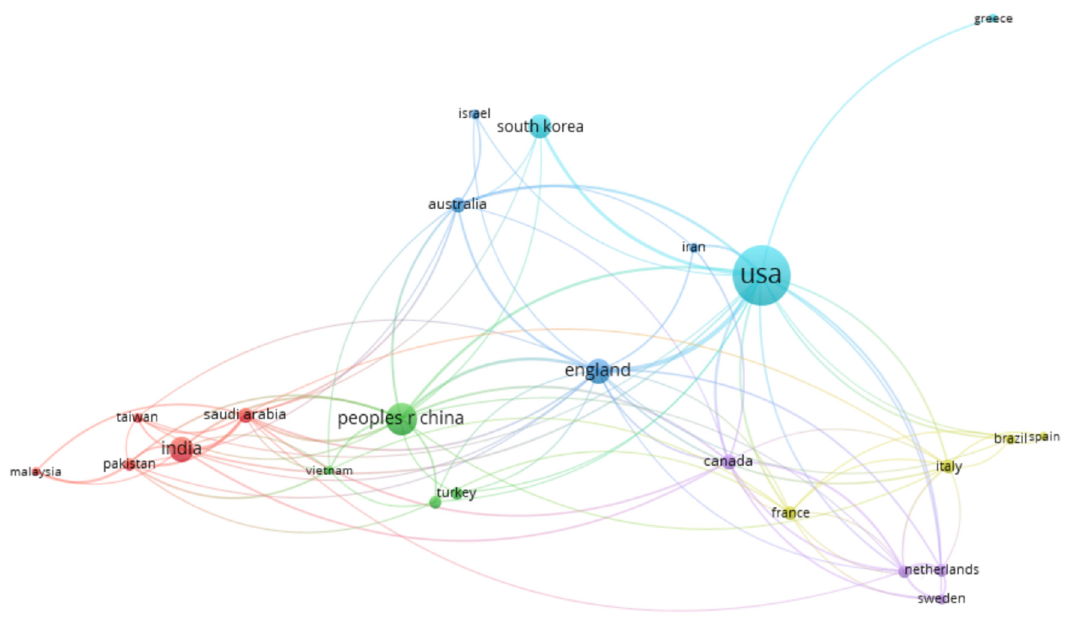
Figure 16. Network by co-authorship.